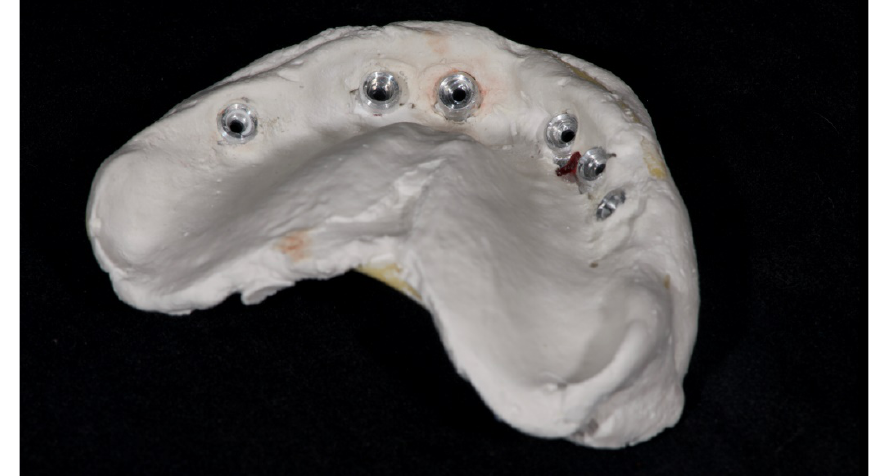
Figure 8. Analogical transfer screwed on OT Equator for classic impression technique. Materials 2020 , 13 , x FOR PEER REVIEW